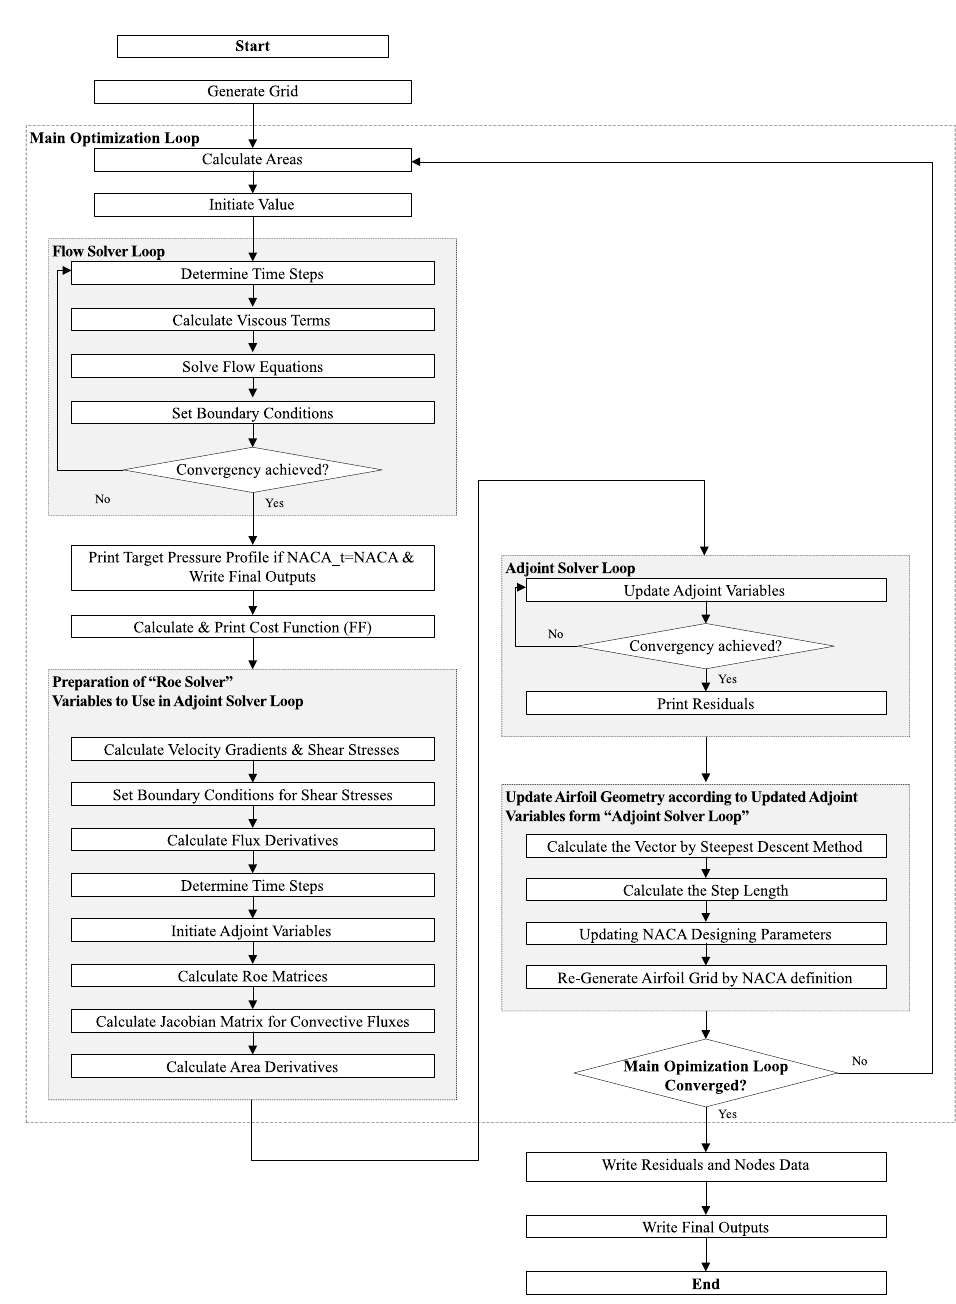
Figure 1. The algorithmic flowchart for the shape optimization procedure involves solving the flow field equations, formulating and solving the adjoint equations, computing the converged adjoint variables, and determining the optimization direction based on the adjoint solver